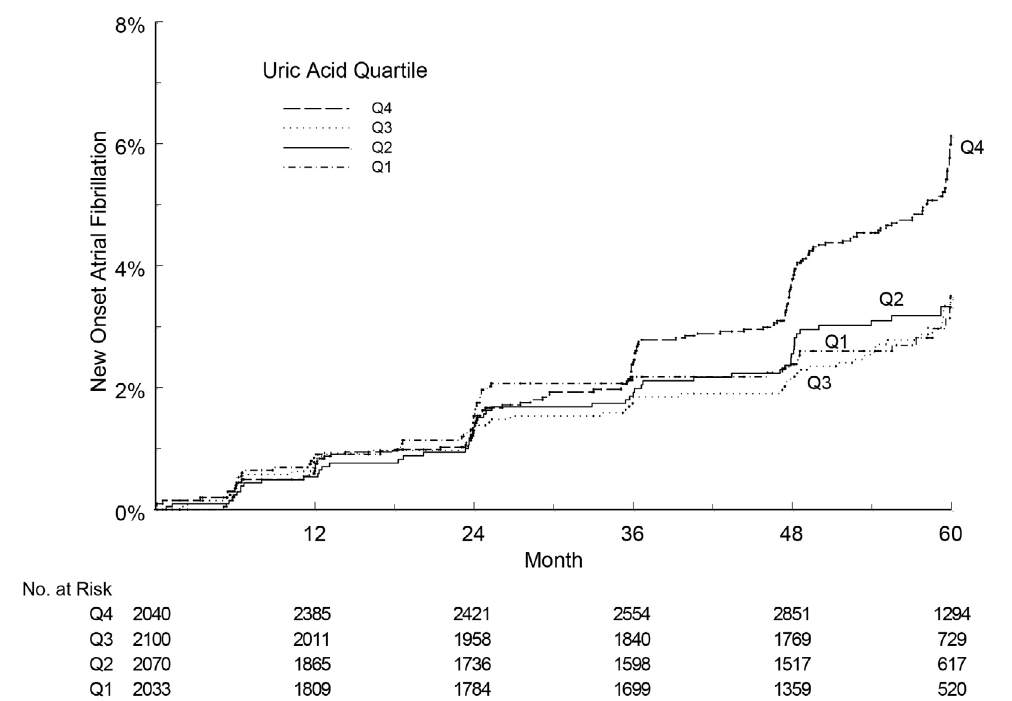
Figure 1. The incidence of new-onset AF (vertical axis) was higher in the 4th quartile than in lower quartiles of sex-specific SUA during five years of antihypertensive treatment (horizontal axis) as illustrated by a modified Kaplan-Meier plot. 1st through 4th SUA quartiles at baseline using sex-specific ranges: < 309, 309–353, 354–408, and ≥ 409 µmol/L for men and < 255, 255–297, 298–345, and ≥ 346 µmol/L for women. 1st quartile n = 2,033, 2nd quartile n = 2,070, 3rd quartile n = 2,100, 4th quartile n =